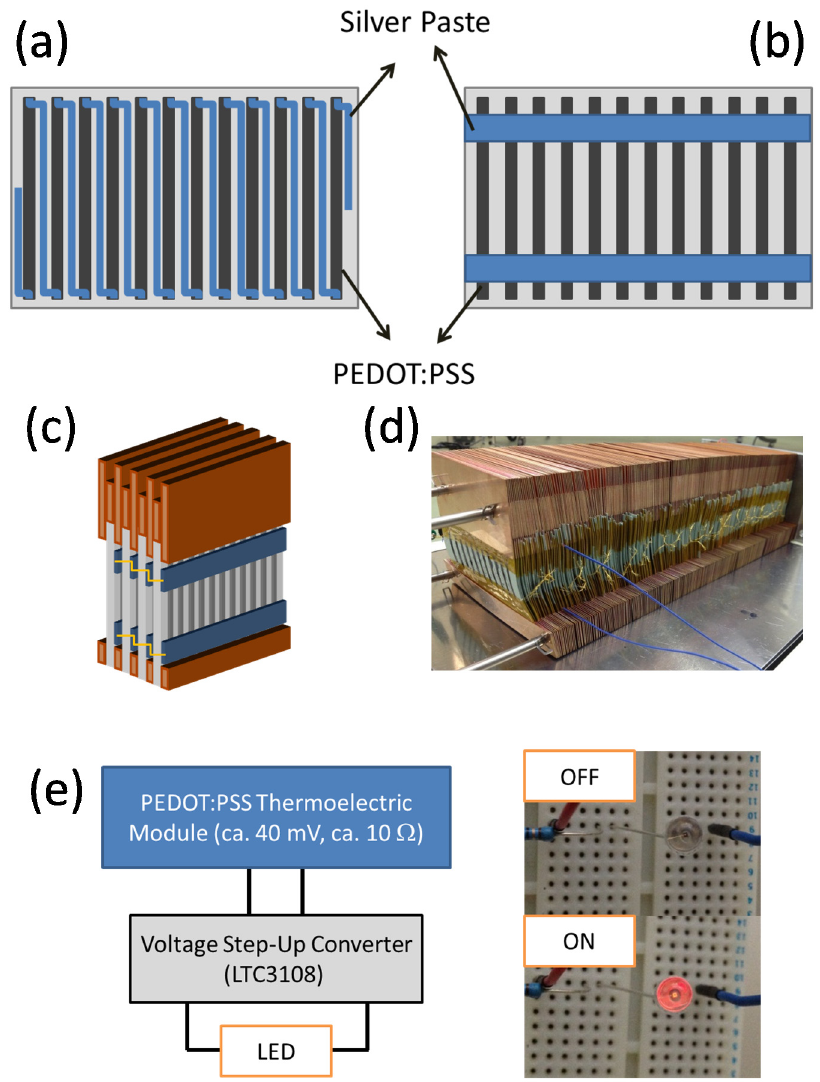
Figure 9. Schematic representation of the ( a ) series and ( b ) parallel PEDOT:PSS array. ( c ) Schematic and ( d ) photograph of the PEDOT:PSS modules sandwiched between copper plates. ( e ) Schematic of the circuit for powering an LED and photograph of the LED driven by the PEDOT:PSS thermoelectric module. Reproduced with permission from [68]. Copyright 2014 The Royal Society of